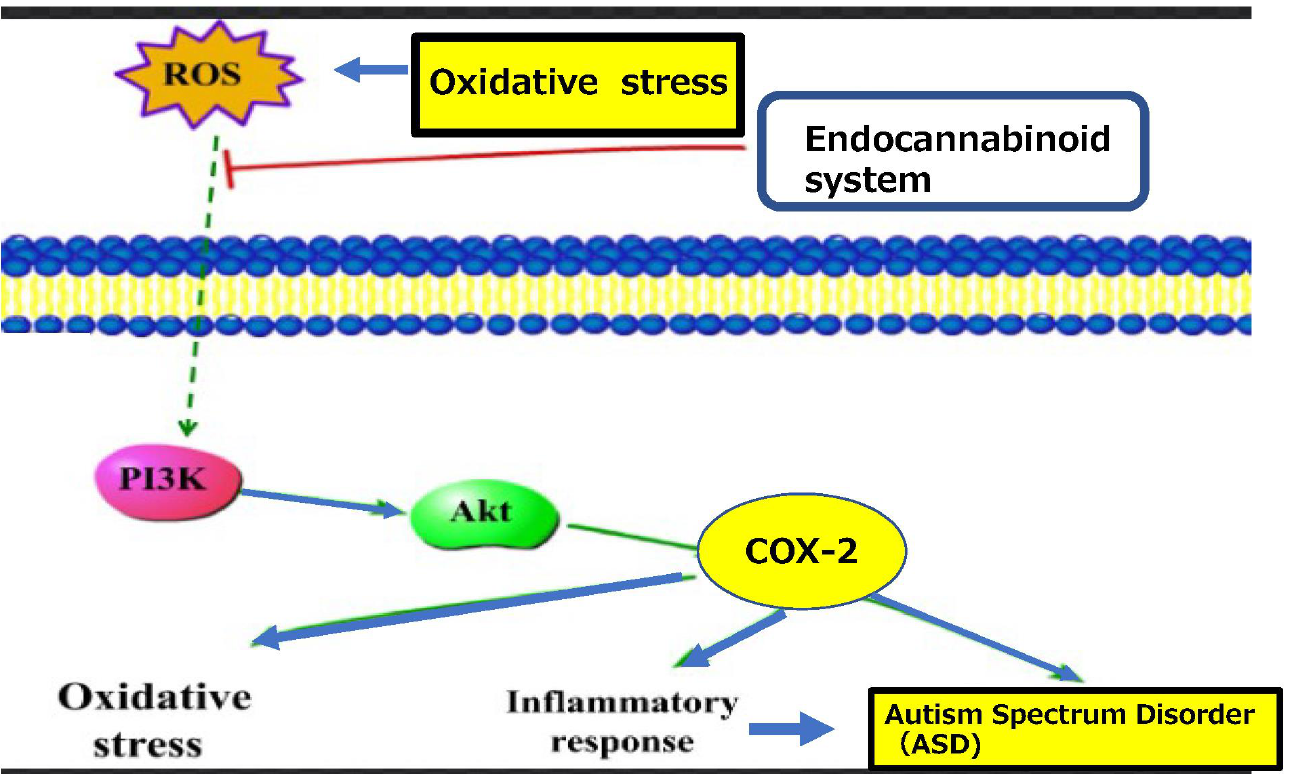
Figure 3. Oxidative stress related oxygen species activate redox signaling which regulates several physiological processes in a wide variety of endocannabinoid syatem in pathophysiological and homoeostatic pathways such as COX-2, inducing neuriinflammation in relation to ASD.